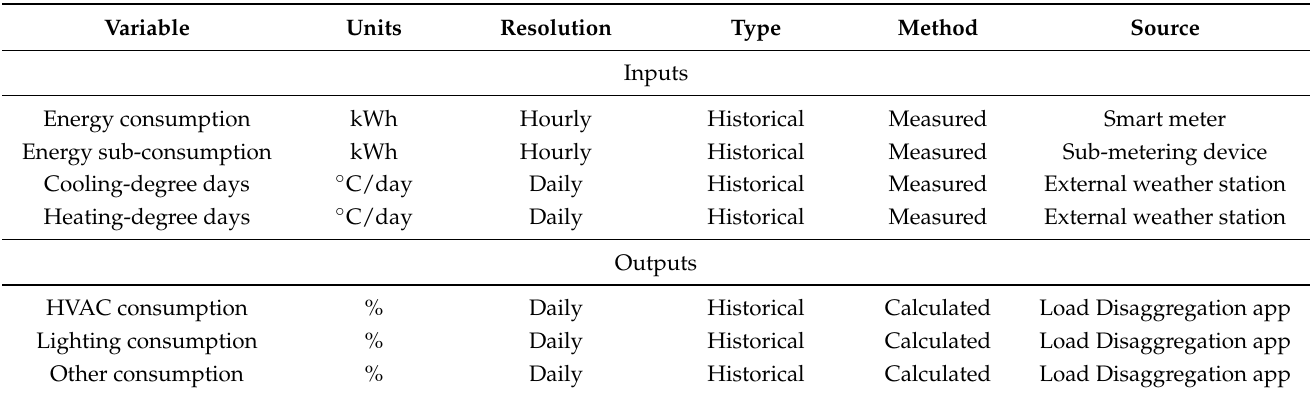
Table 10. Detailed list of inputs and outputs for tertiary Load Disaggregation